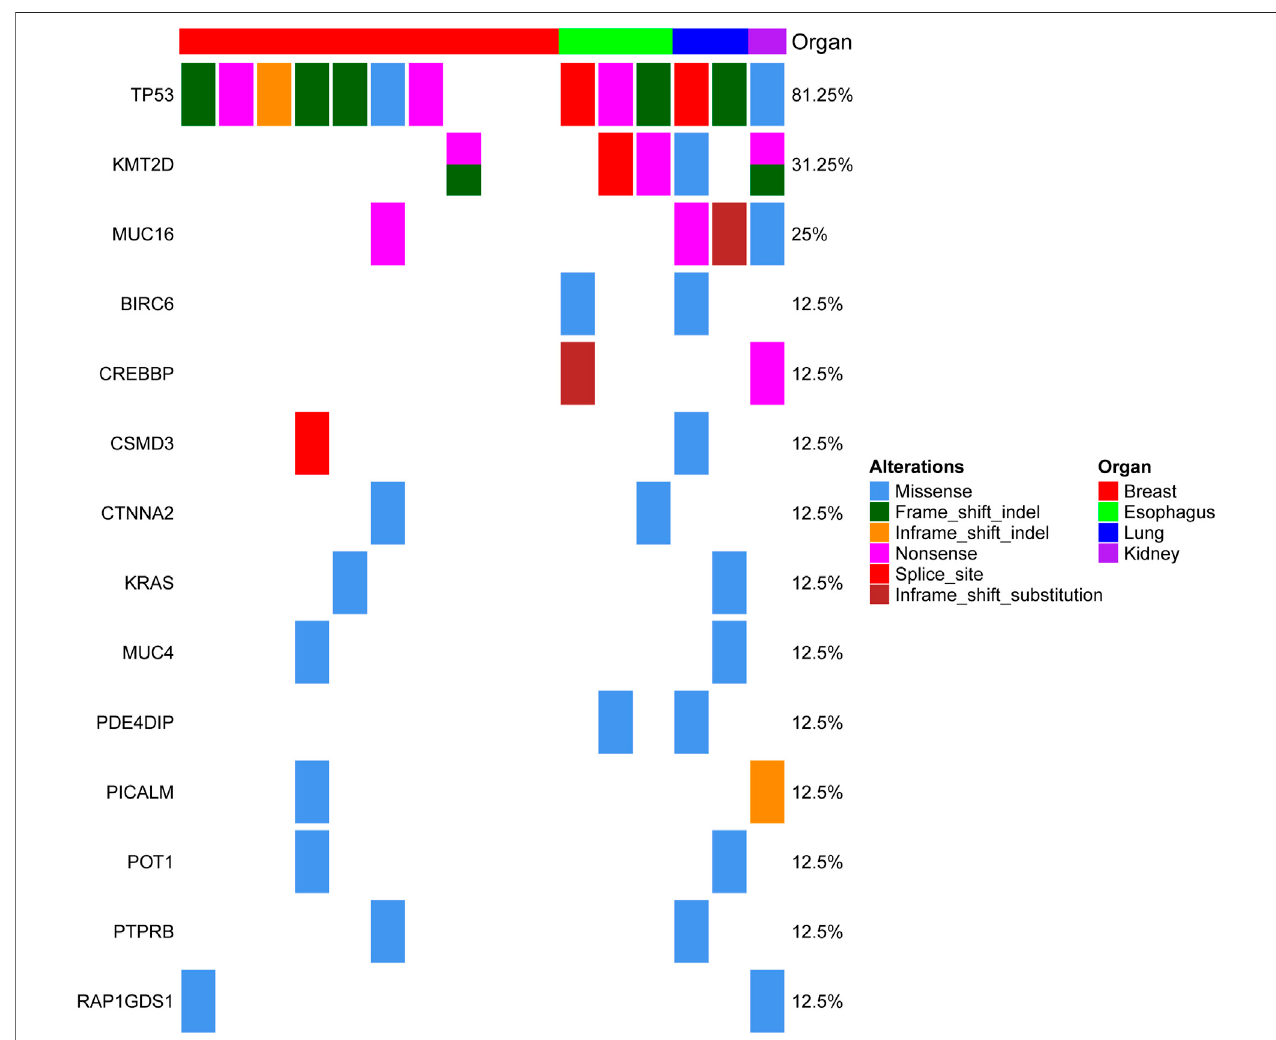
FIGURE 1 | Genomic alterations in MSC from different organs. The matrix represents individual mutations in 16 patient samples originating from four organs (the breast, esophagus, lung and kidney), and the genes with mutations detected in at least two organs are displayed.